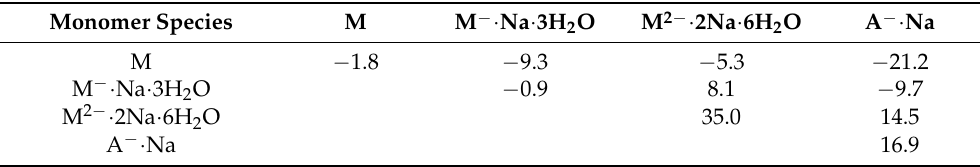
Table 1. Gibbs free energy of dimerization reactions ( ∆ G reaction ; kJ/mol) occurring in an aluminosili- cate solution at a pH of 11